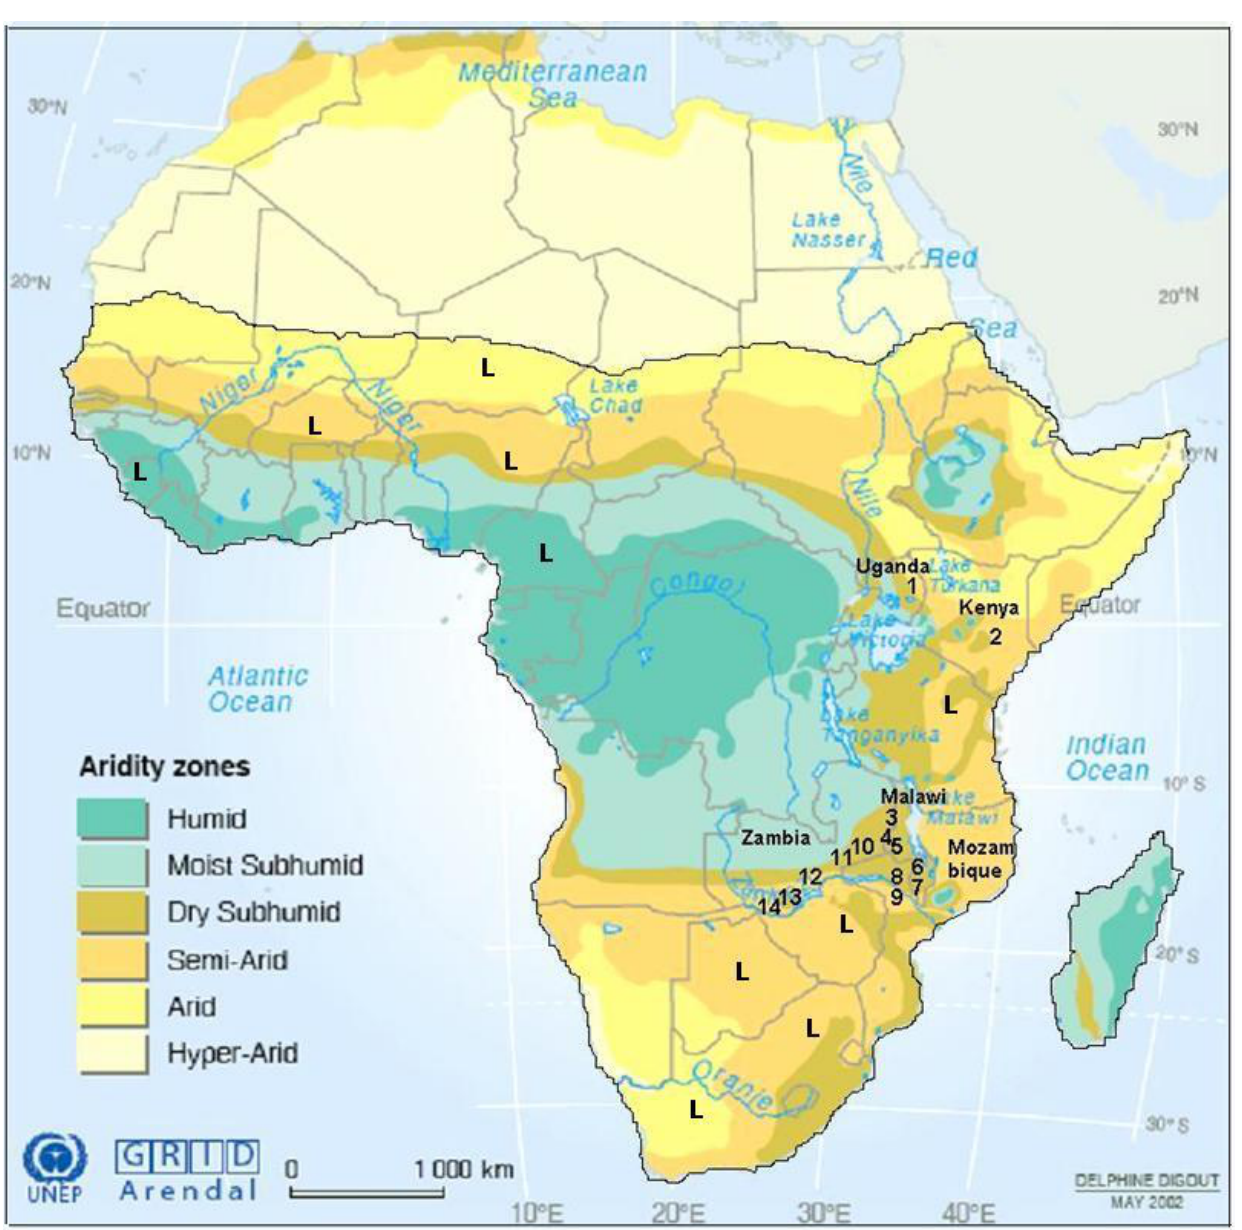
Fig. 1. The specific study sites and countries in Sub-Saharan Africa (in black outline) for which literature (L) was available for this synthesis. The specific sites are (1) Tororo district in eastern Uganda, (2) Machakos district in eastern Kenya, (3) Kasungu, (4) Mchinji, (4) Dedza, (5) Ntcheu, (6) Balaka, and (7) Zomba districts in Malawi, (8) Angonia and (9) Tsangano districts in northwest Mozambique, (10) Chipata and (11) Katete in eastern Zambia, (12) Mazabuka and Monze, (13) Gwembe and Choma, and (14) Kalomo and Livingstone districts in southern Zambia. The study sites were superimposed on the aridity map of Africa (UNEP/GRID-Arendal